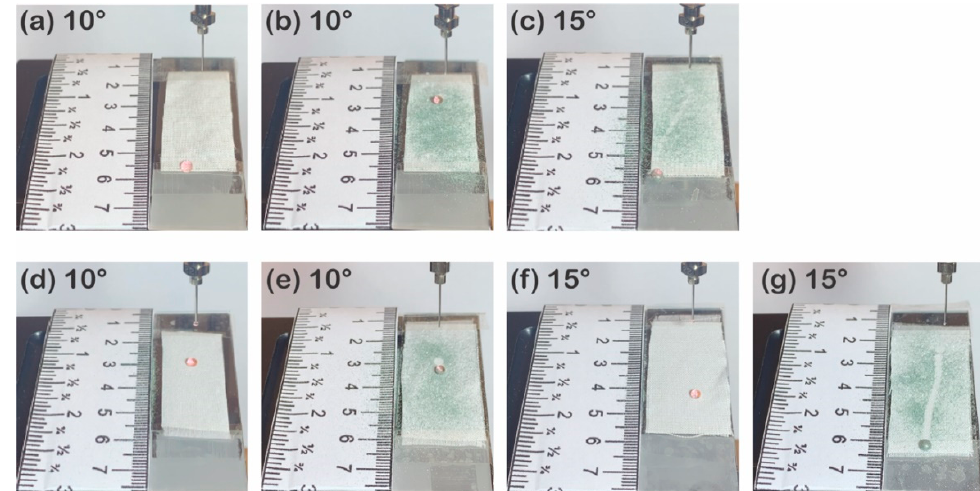
Figure 6. Self-cleaning tests of P1T1 PDMS-coated staple fabric without silicon carbides tilted at 10° ( a ) and with silicon carbides tilted at 10° ( b ) and 15° ( c ) and P1T1 PDMS-coated filament fabric without ( d ) and with (e) silicon carbides tilted at 10° and without (f) and with (g) silicon carbides tilted at 15°.